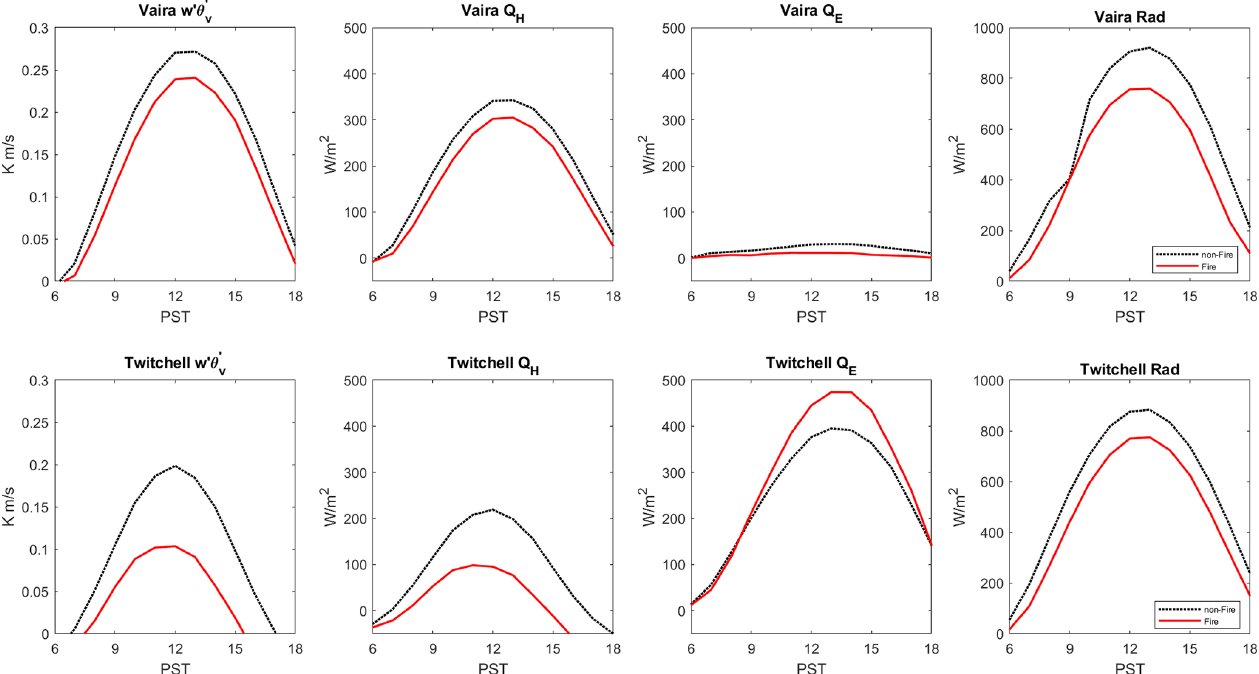
Figure 7. Measurements of buoyancy flux ( w (cid:48) θ (cid:48) v ), sensible heat flux ( Q H ), latent heat flux ( Q E ), and incoming solar radiation (SSWD) at Vaira Ranch (top row) and Twitchell Wetland (bottom row). Solid red lines are averaged profiles during wildfire periods (June–September) from 2016 to 2019. Dashed black lines are the averaged profile for non-fire days.